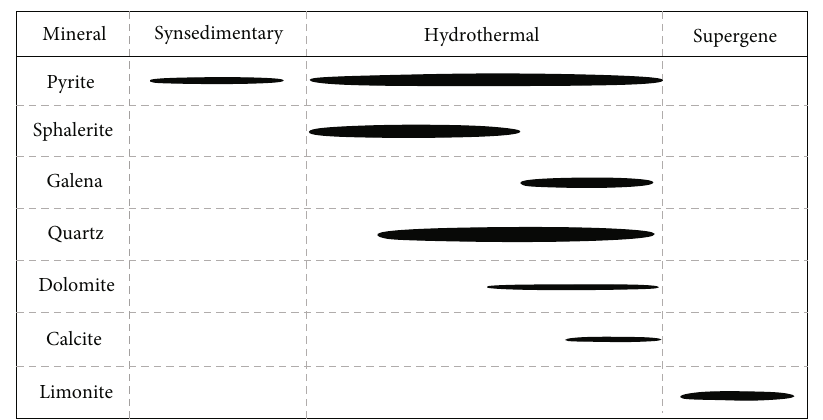
Figure 4: Mineral assemblages in the paragenetic sequence of the Laoyingqing Pb – Zn